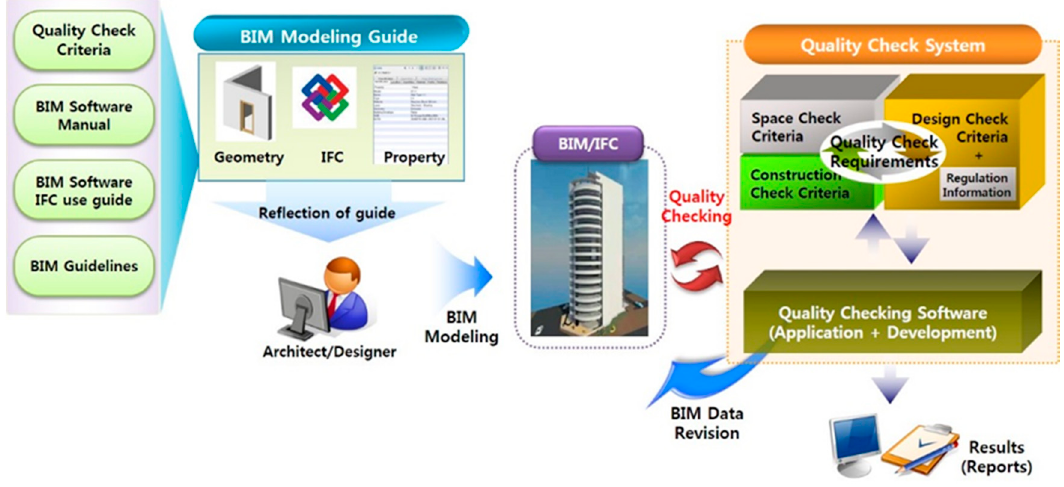
Figure 2. Process and element technology for the application of quality checking.